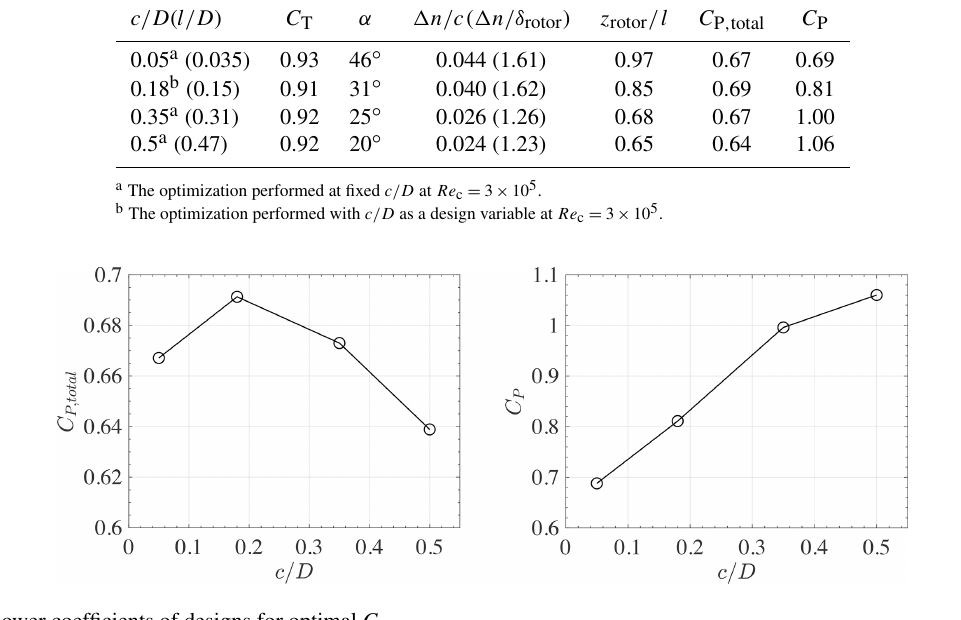
Figure 6. The power coefficients of designs for optimal C P , total